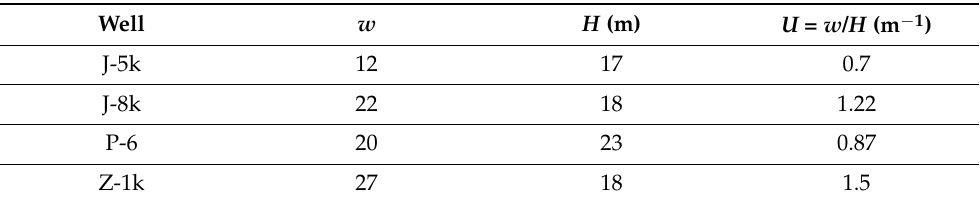
Table 1. Ranking of the wells for the performance of the WSO treatment based on the interpretation of